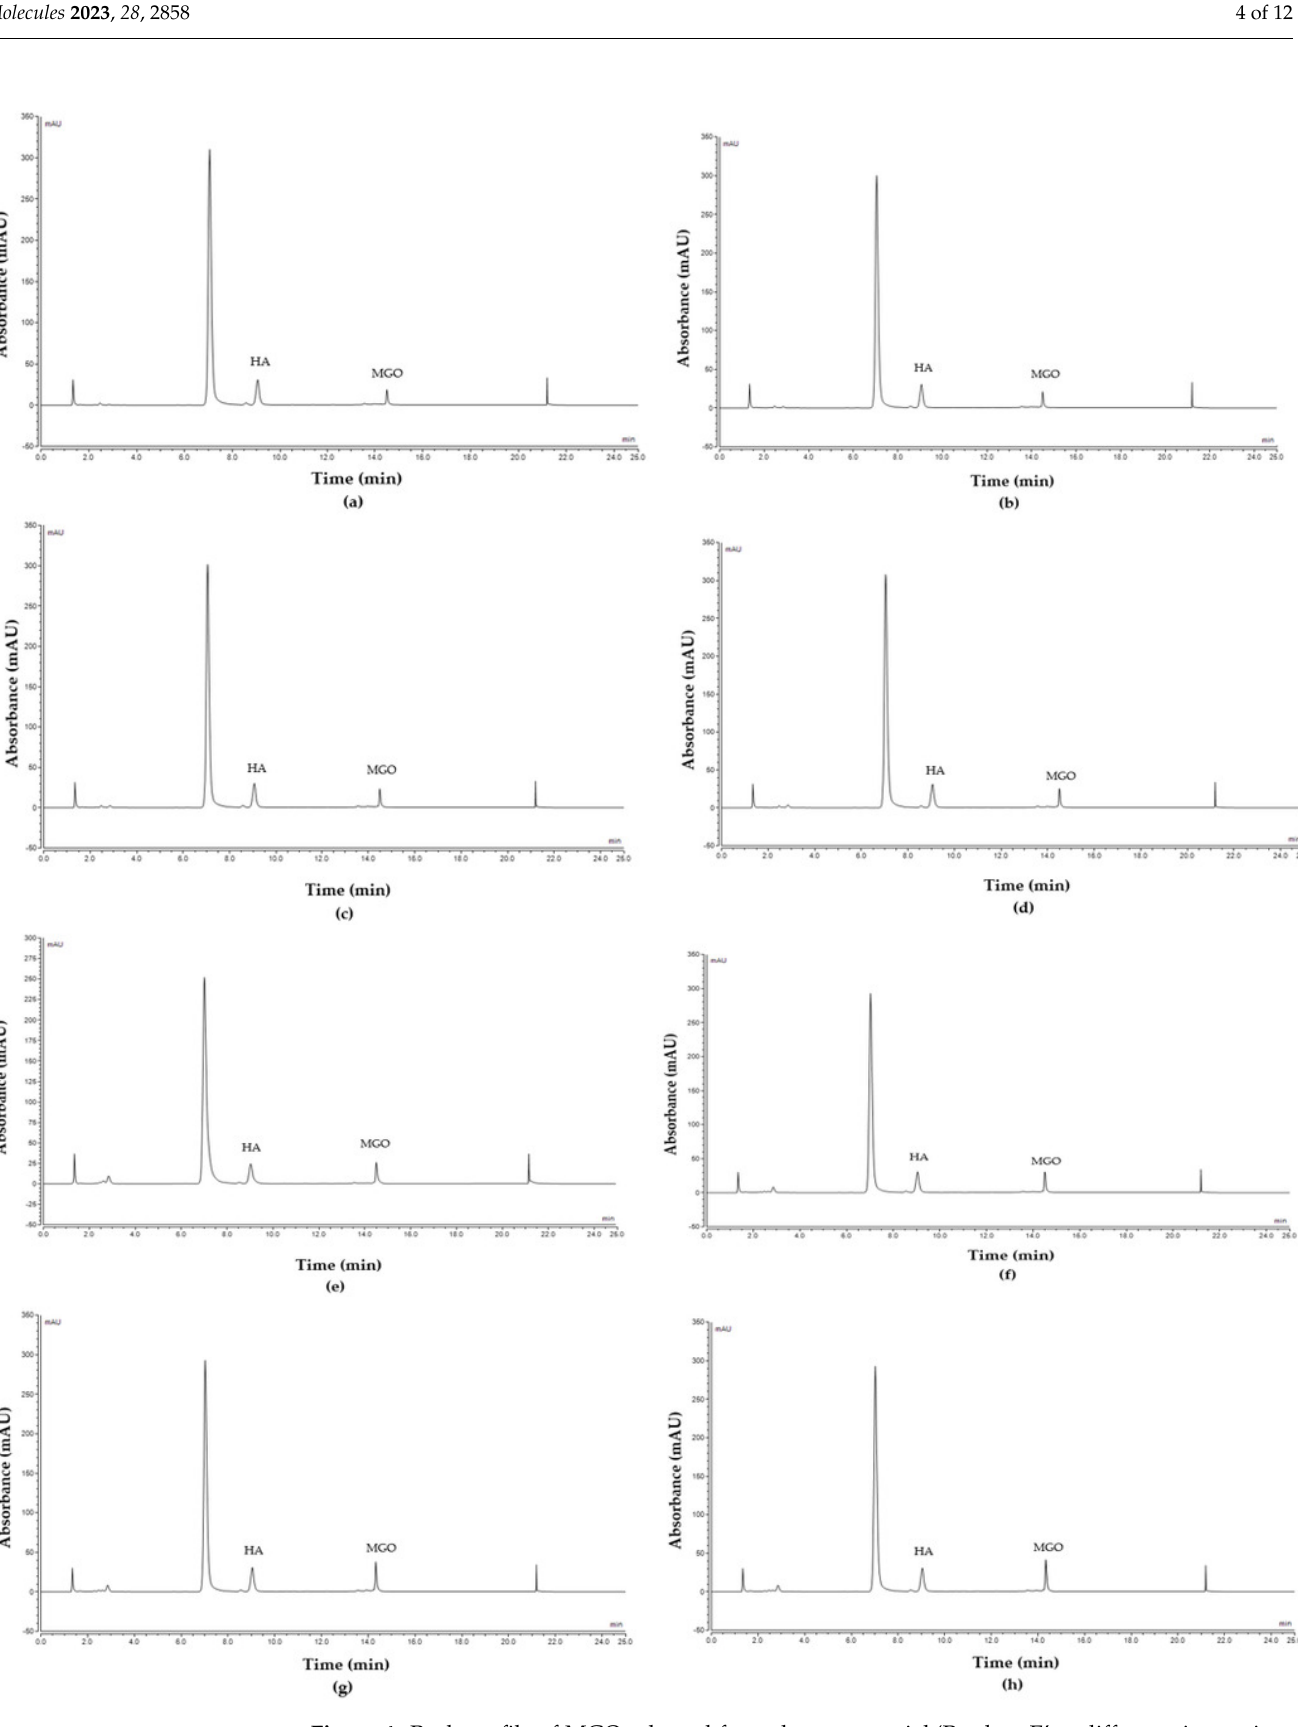
Figure 4. Peak profile of MGO released from the commercial ‘Product E’ at different time points: ( a